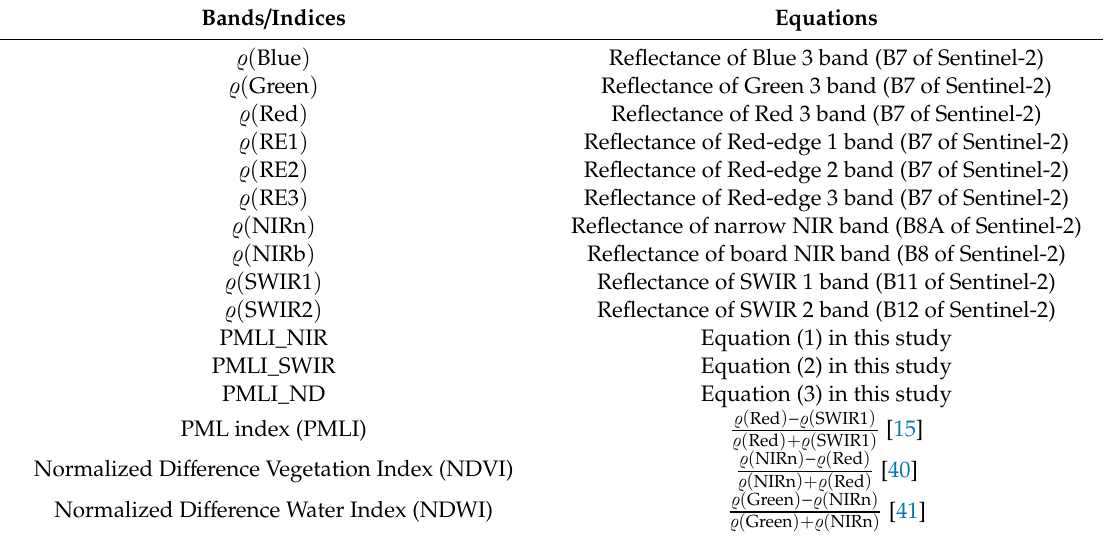
Table 1. Features extracted from the Sentinel-2